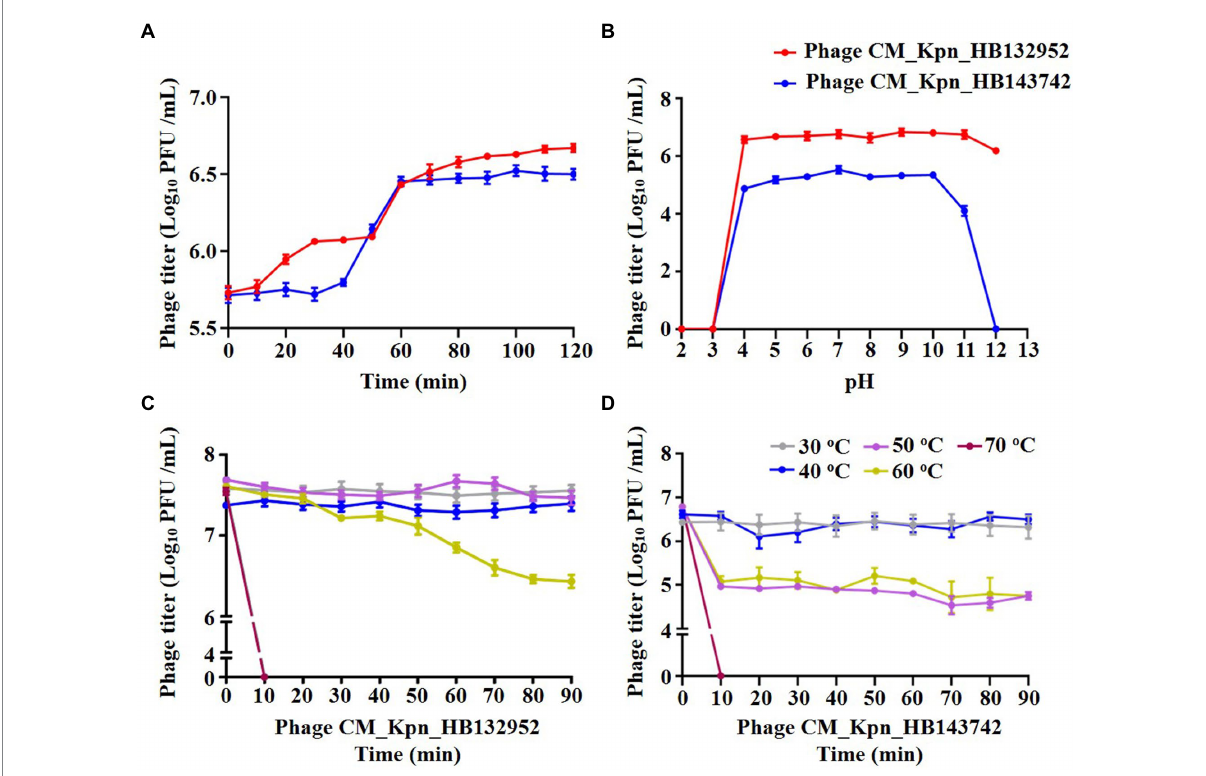
FIGURE 3 Biological property analyses of phages. (A) One-step growth curve of phage CM_Kpn_HB132952 (red) and CM_Kpn_HB143742. (B) Acid–base stability of phage CM_Kpn_HB132952 (red) and phage CM_Kpn_HB143742 (blue). (C,D) Thermal stability of phage CM_Kpn_HB132952 and phage